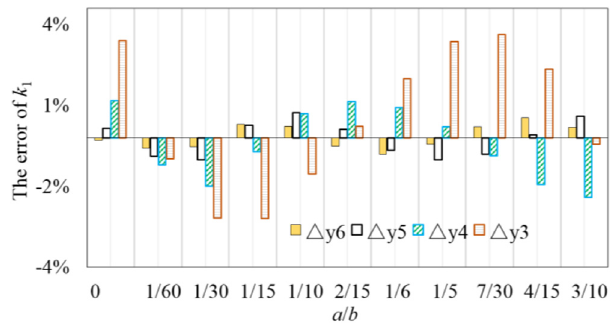
Fig. 17. The errors of the reduction coef fi cient k 1 of the square plate with circular hole.